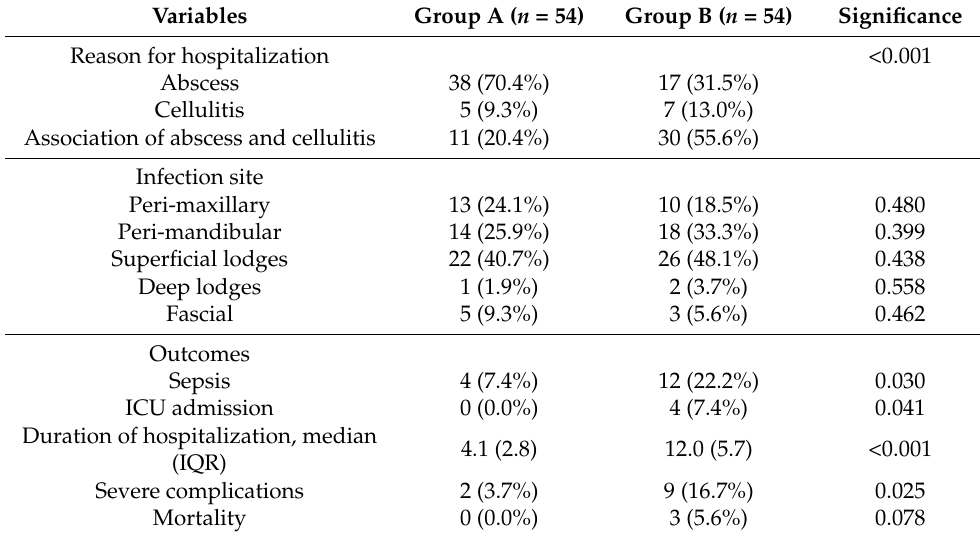
Table 3. Comparison of infection characteristics among patients with odontogenic infections. Variables Group A ( n = 54) Group B ( n =